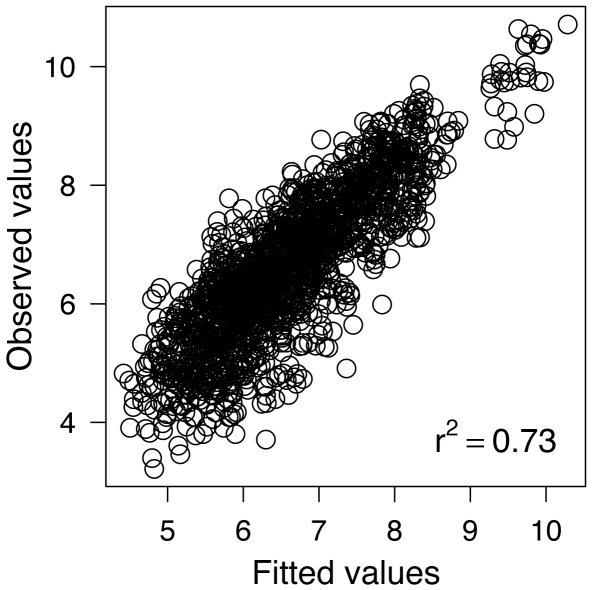
Model evaluation.Observed versus within-group fitted values plot for model depicted in Table 1. Note that the values on the extreme upper right side of the figure correspond to Tanaelva, which is the largest river along Norway in terms of catches (see Fig. 2A, and Table S1).